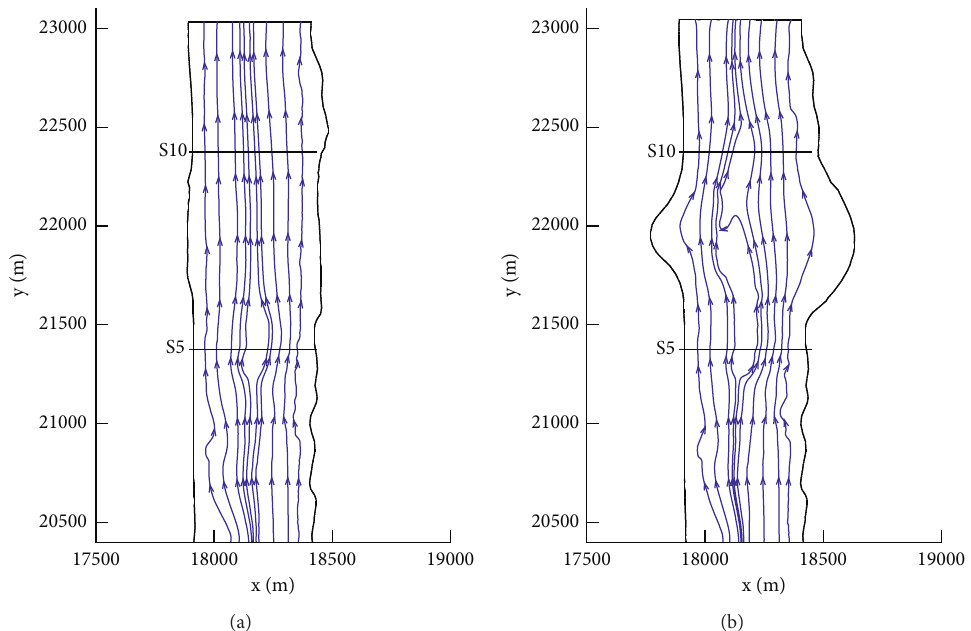
Figure 9: Comparisons of streamlines before and after river reconstruction for a 10-year flood. (a) Before reconstruction. (b) After